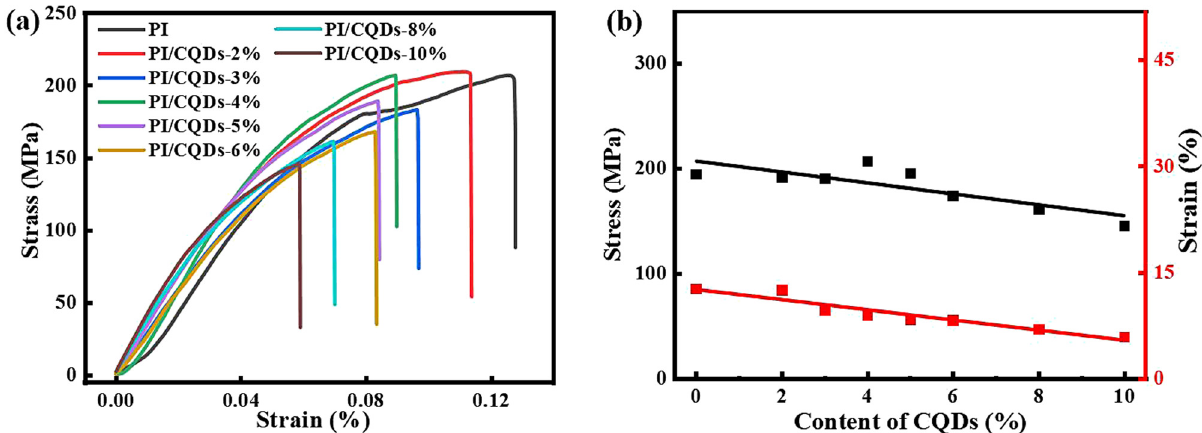
Figure 6: Mechanical properties of PI/CQD composite fi lms: ( a ) stress – strain curve, ( b ) the variation trend of stress and strain with CQD content.